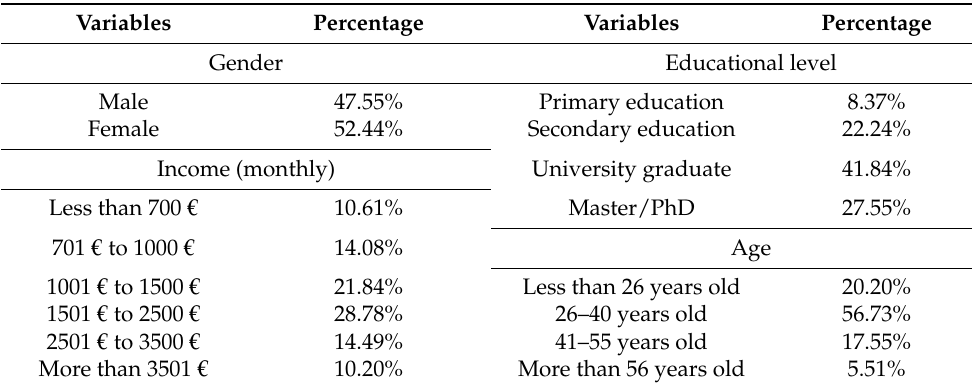
Table 1. The respondents’ sociodemographic characteristics.